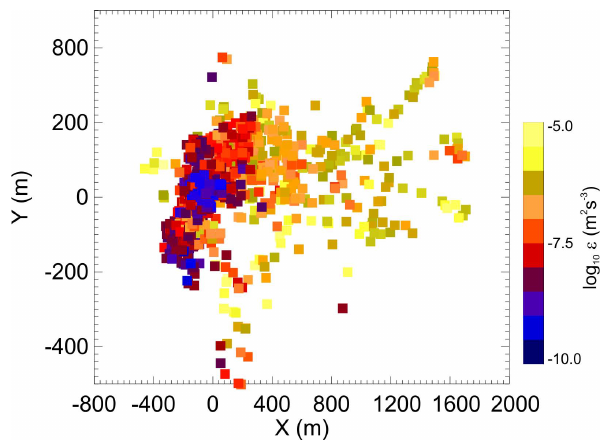
Fig. 12. All dissipation rate estimates over the 24h sampling period as a function of pseudo “horizontal displacements” X and Y using a timescale of